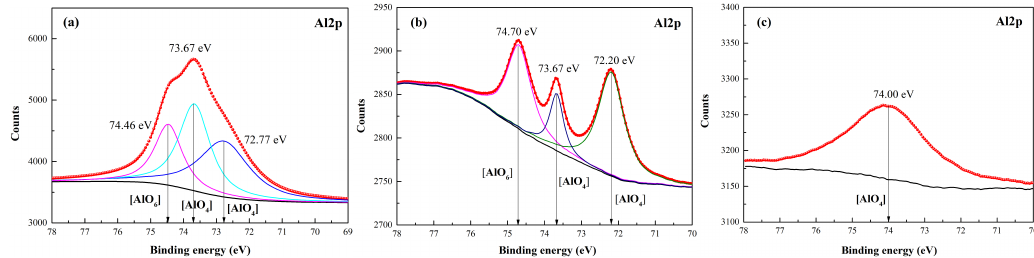
Figure 9. XPS fine spectrums of Al2p in ( a ) the black shale, ( b ) the NLR and ( c ) the KLR obtained after leaching with 4 mol/L H 2 SO 4 and 7wt% K 2 SO 4 at 150 °C for 5 h.